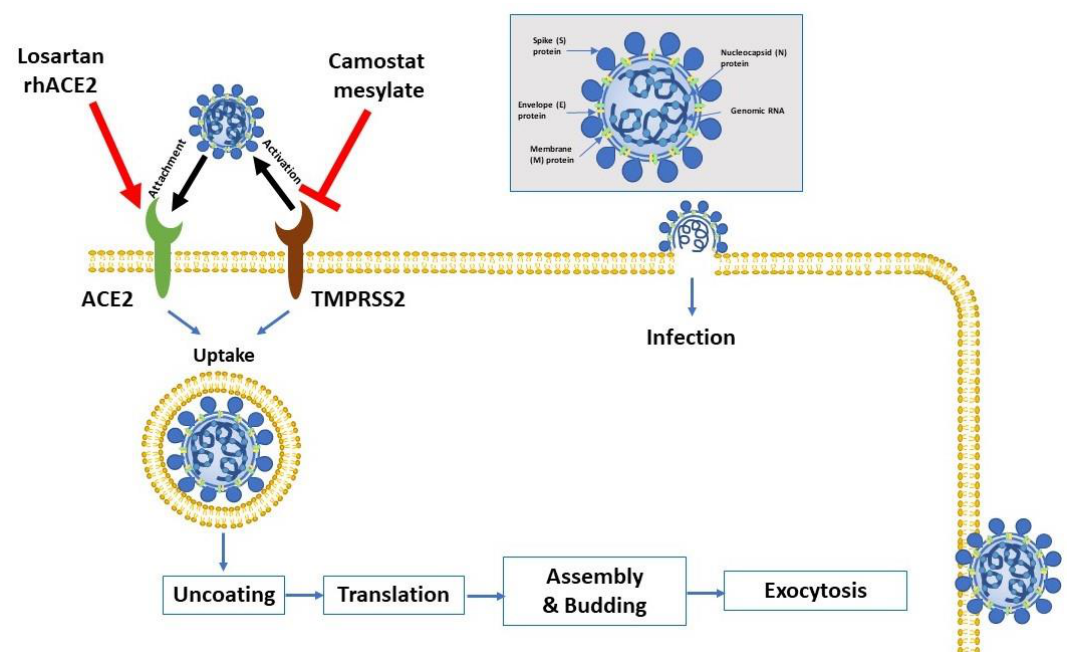
Figure 1. Virus entry into the host cell. The attachment protein “-spike glycoprotein” of the severe acute respiratory syndrome-2 (SARS-CoV-2) uses a cellular attachment factor (angiotensin-converting enzyme 2 (ACE2)) and uses the cellular protease TMPRSS2 (transmembrane protease serine 2) for its activation. ACE2 can be activated via either losartan or recombinant human ACE 2